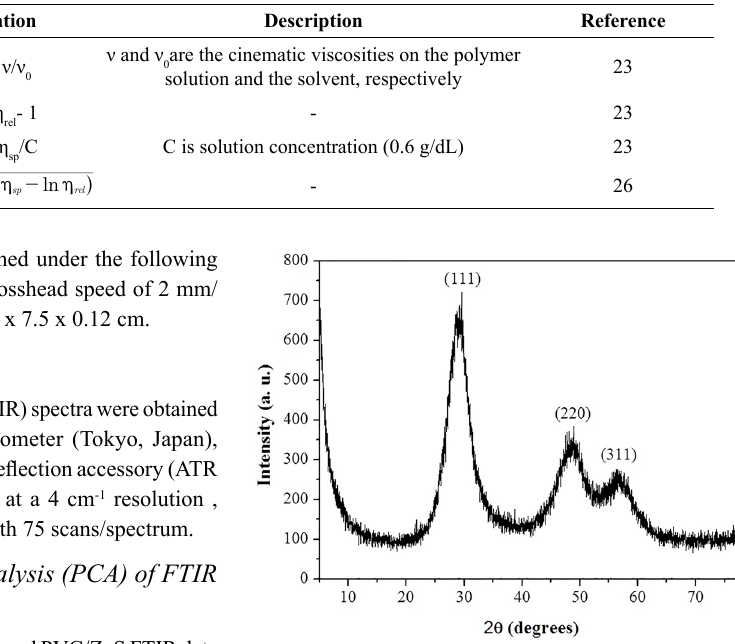
Figure 1. XRD pattern of ZnS nanoparticles.